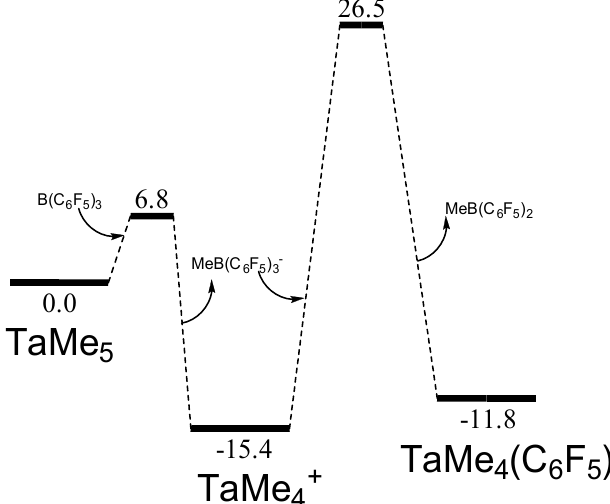
Figure 4. Reaction pathway for the demethylation of TaMe 5 with B(C 6 F 5 ) 3 and next C 6 F 5 anionic transfer (Gibbs energies in kcal/mol referred to TaMe 5 ).